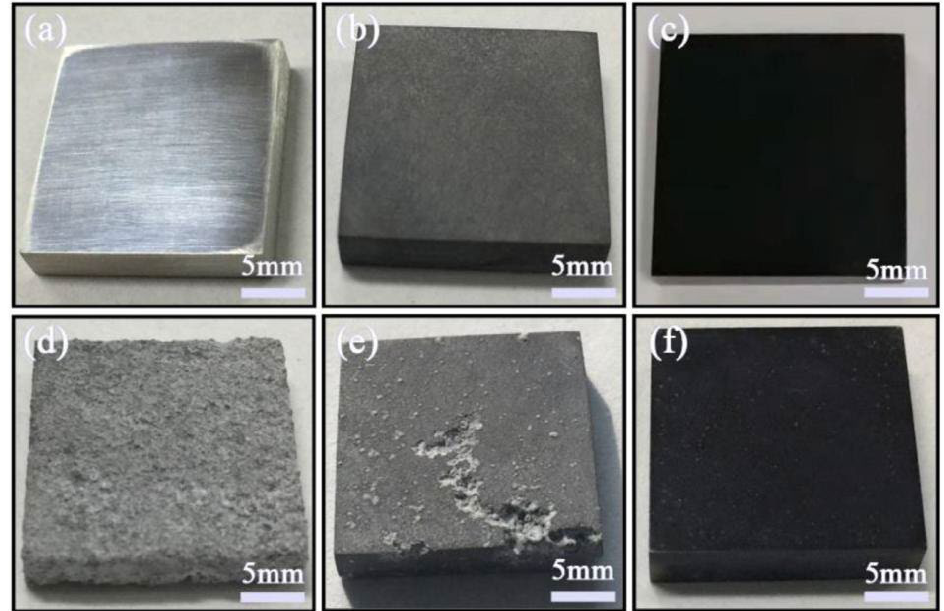
Figure 50. Photographs of ( a , d ) bare AZ31, ( b , e ) AZ31 + FLMs and ( c , f ) AZ31 + Y + FLMs before and after being immersed in 3.5 wt.% NaCl solution for 15 days. Reprinted with permission from [86]. Copyright 2021 Elsevier.